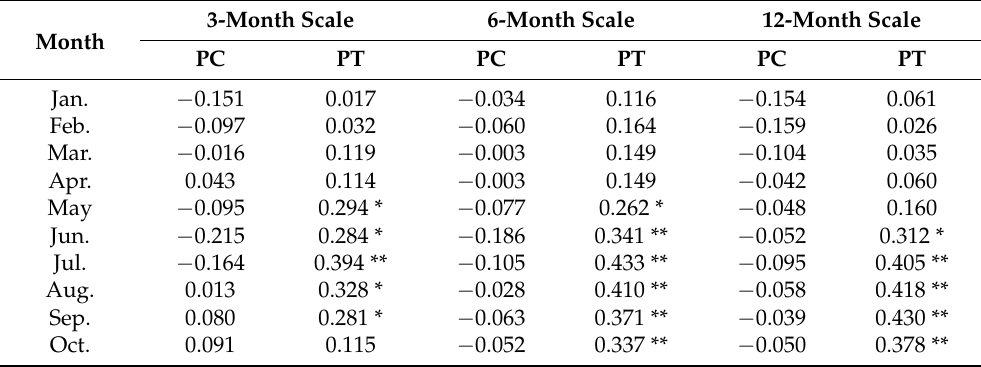
Table 4. The correlation relationship between the radial growth of the two dominant coniferous species and the SPEI